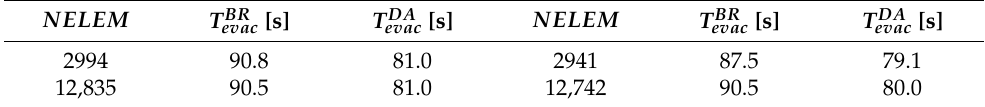
Table 3. H-shape domain, FV (left) and FV-DG (right), NELEM = # T h , T BR evac = evacuation time